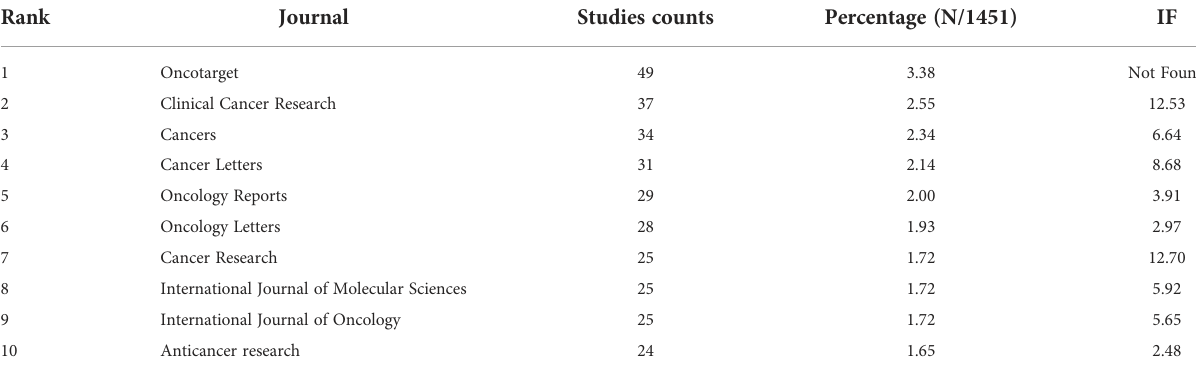
TABLE 2 Top 10 productive journals related to drug resistance in colorectal cancer. Rank